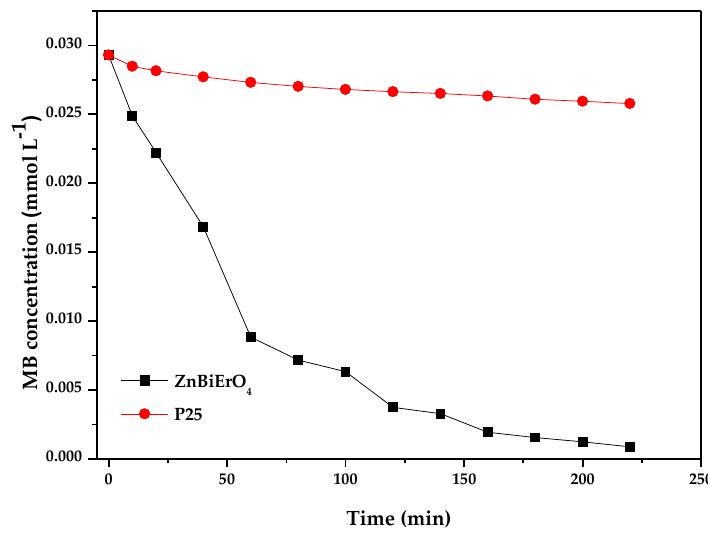
Figure 18. Photocatalytic degradation of methyl blue with ZnBiErO 4 or P25 as catalyst under visible light irradiation.